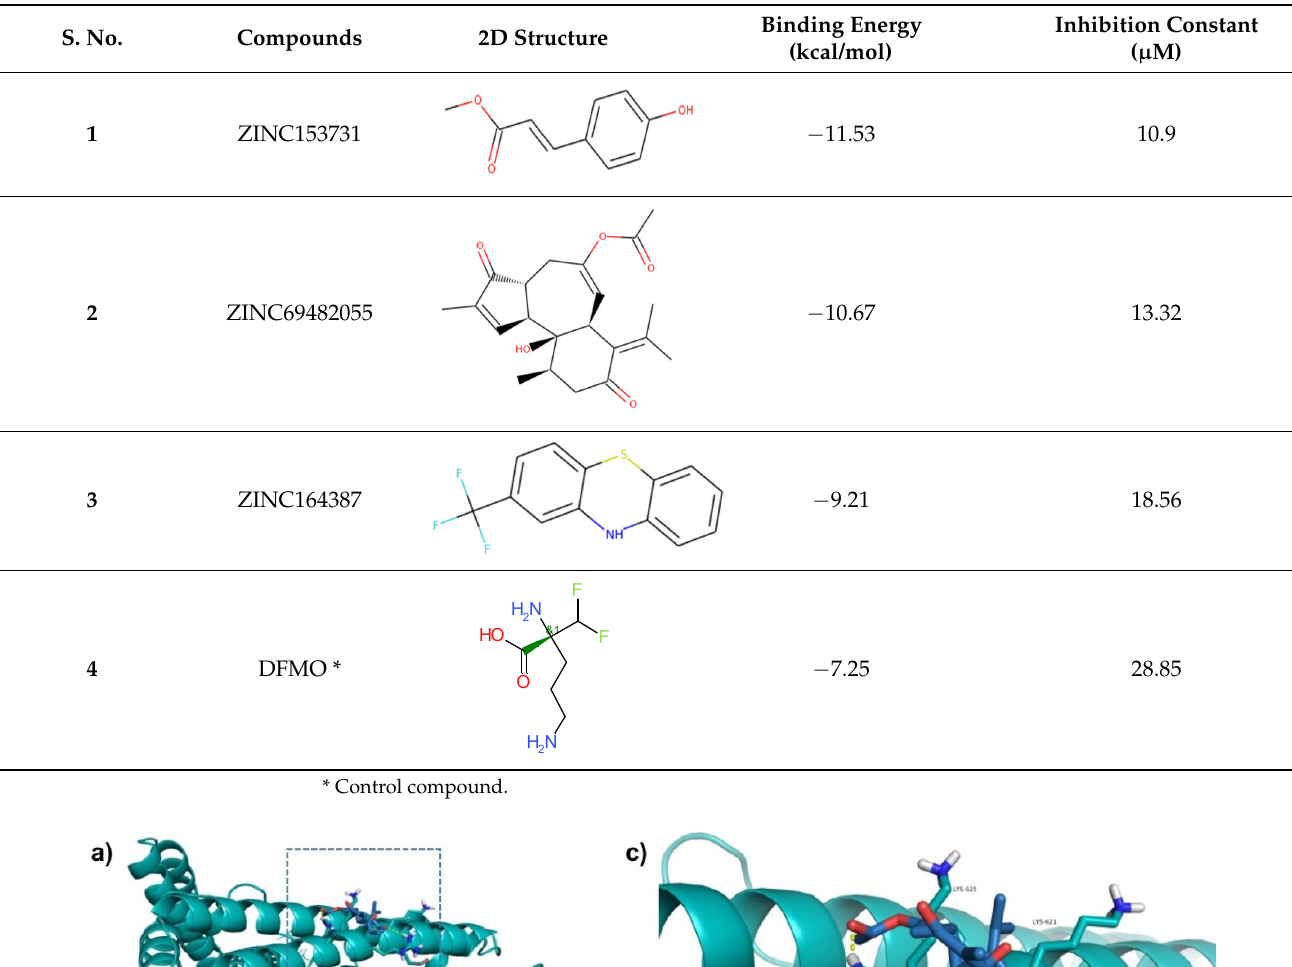
Table 3. BE of compounds with CagA protein.